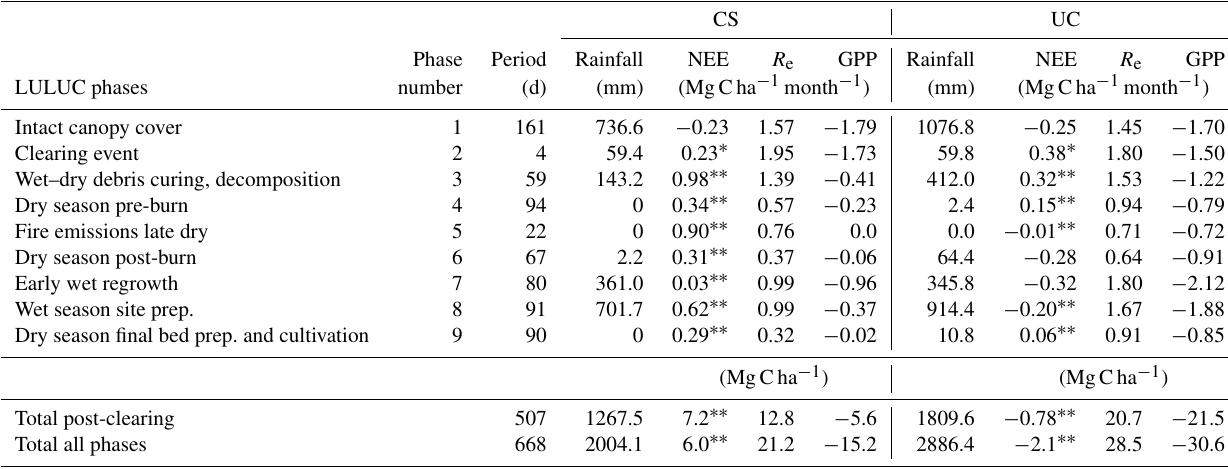
Table 3. Cumulative precipitation and mean NEE, R e and GPP (MgCha − 1 month − 1 ) for each of the LUC phases at the CS site as measured by the flux tower. These fluxes are given for the UC site for these same periods. One-way ANOVA was used to test for differences between mean daily NEE for each LUC phase with significantly different means labelled with an asterisk. On the days of ignition during the debris burning phase, flux data at the CS site were excluded. Integrated fluxes are given for the post-clearing period (507 days) and the entire observation period (668 days) for both sites in MgCha − 1